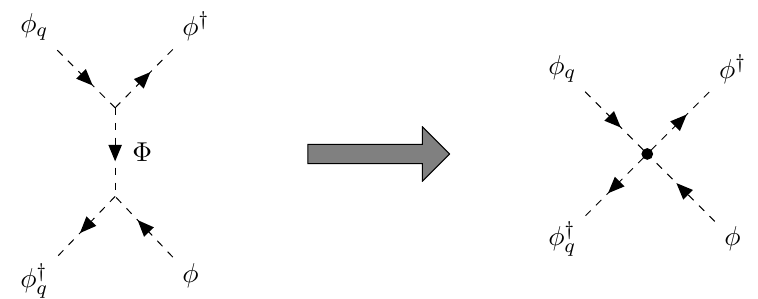
Figure 1 . Pair production φ q φ † → φφ † through the t -channel exchange of a heavy complex scalar q Φ . The EFT description can be obtained by expanding and truncating the t -channel propagator, yielding a series of local